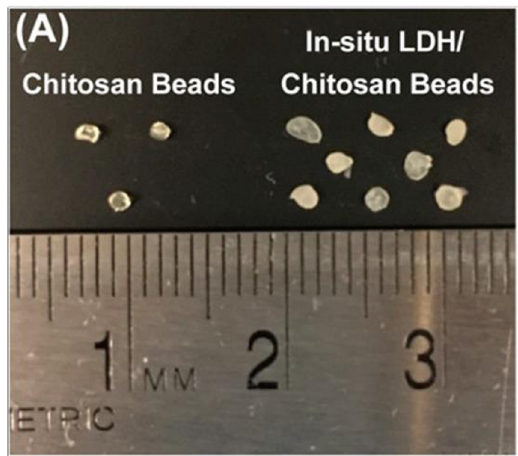
Figure 11: CS beads and MgAl – LDH/CS beads [ 141 ] .